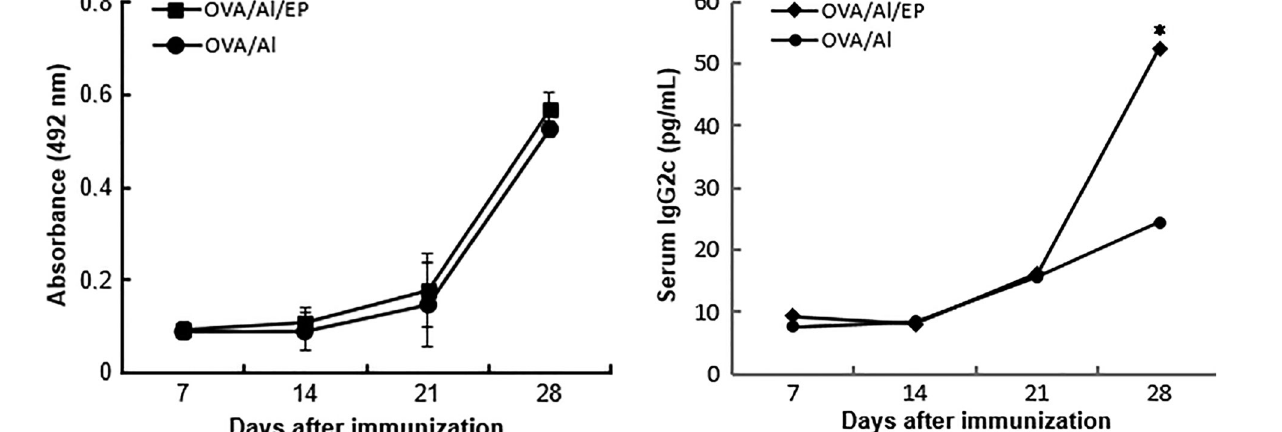
Figure 1. Evaluation of the effect of enalapril (EP) on ovalbumin (OVA)-speci fi c IgG1. Two groups of mice (3 – 4/group) were subcutaneously immunized with OVA/Alhydrogel (Al) and boosted at day 21. The mice were orally treated with enalapril or were left without treatment. OVA-speci fi c IgG1 was determined by ELISA using 1:400 diluted serum. Data are reported as means ± SD and represent 2 independent experiments.